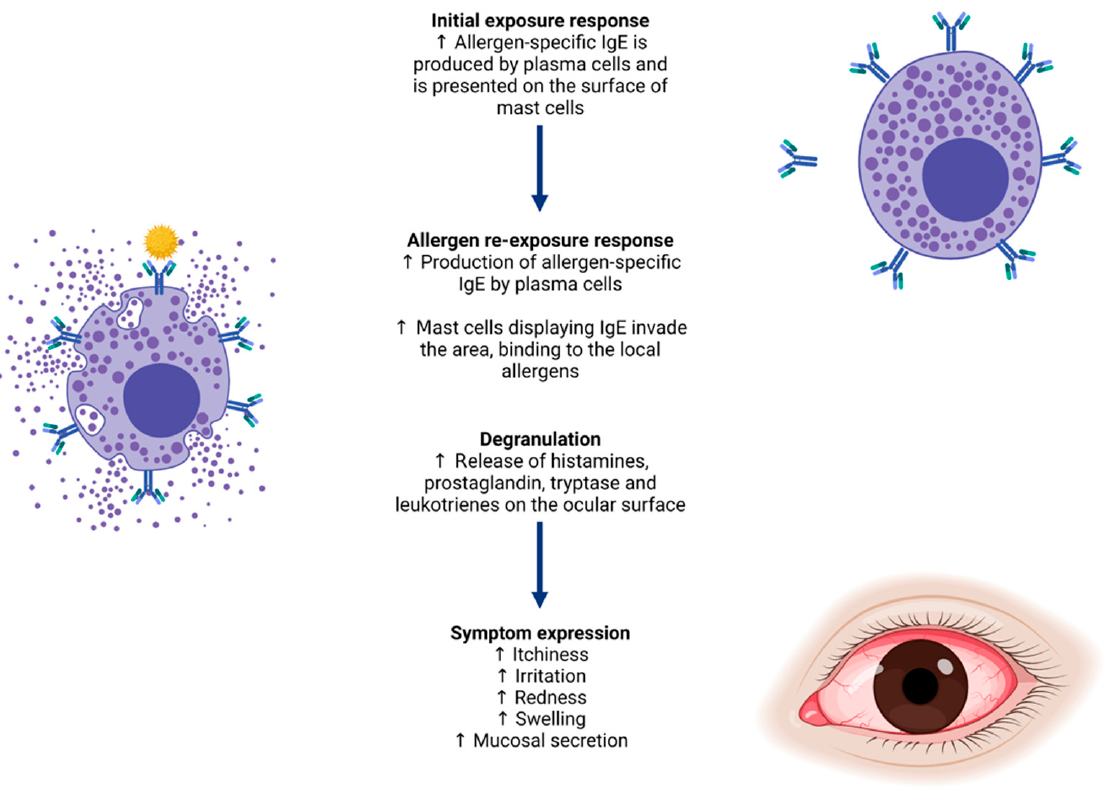
Figure 1. Allergy biopathway from immunoglobulin E (IgE) production for a specific allergen, to signs and symptoms of ocular allergy experienced upon re-exposure. These include itchiness, redness, swelling, irritation and inflammation of the ocular surface and surrounding tissues.